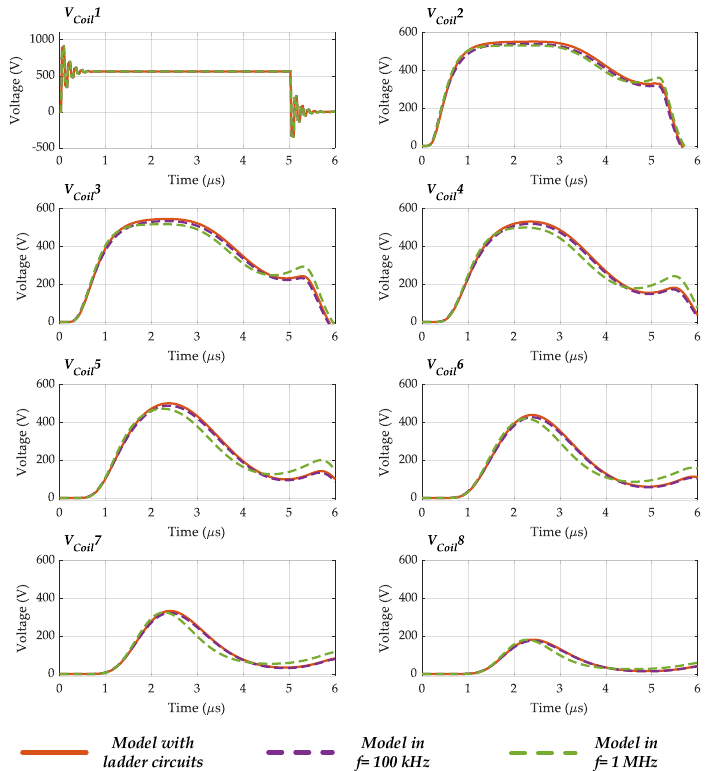
Figure 24. The voltage in different coils when the MCTL model with ladder circuits is developed and fixed-frequency models are developed; the neutral point is grounded.